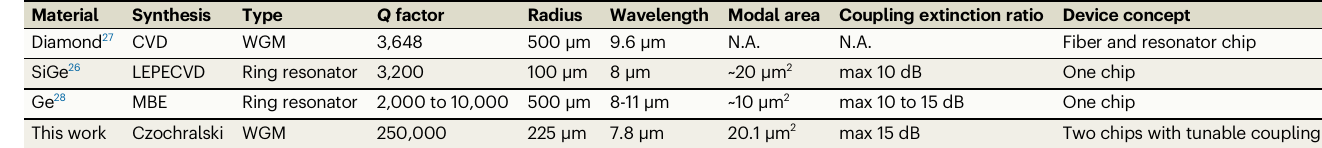
Table 1 | Comparison of previous LWIR